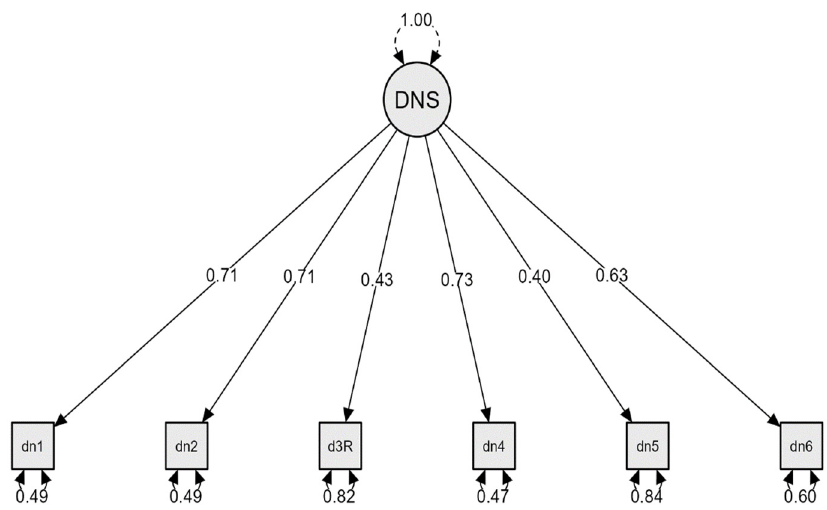
Figure 1. Single-factor model of the DNS with the standardised factor loading. Note: dn1–dn6 = items DNS.